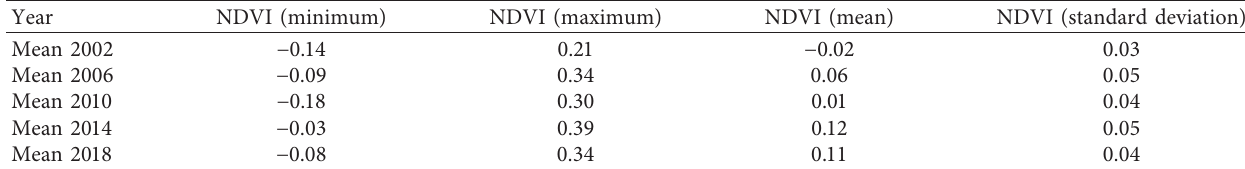
Table 6: Temporal variations of NDVI in the area above mean LST